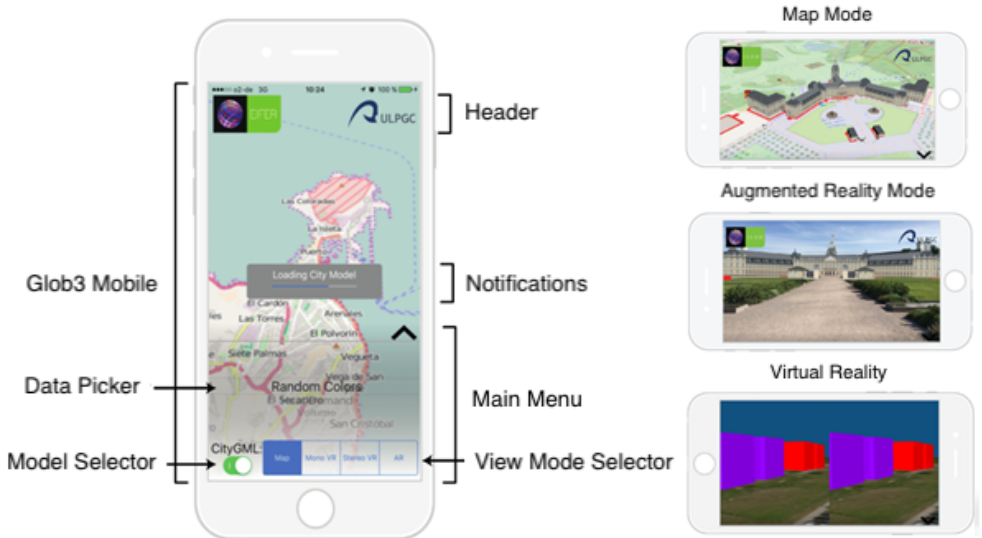
Figure 2. User interface layout for iOS and the three implemented visualization modes.